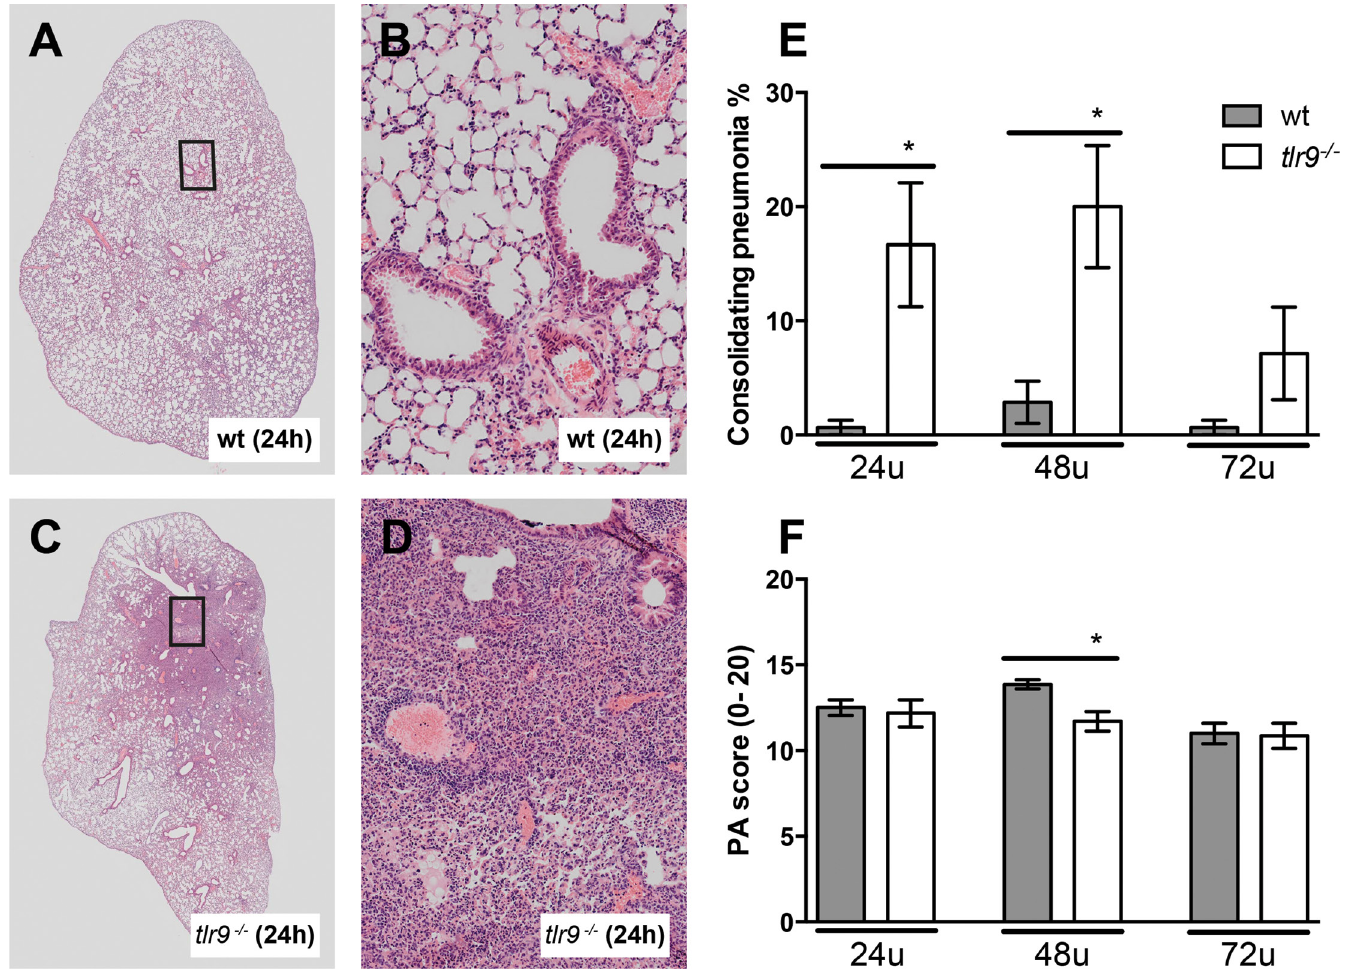
Figure 5. Tlr9 –/– mice show more consolidating pneumonia after induction of S . aureus pneumonia. Representative slides of lung HE staining of (A, B) Wt mice and (C, D) tlr9 –/– mice. (A, C) depiction of a whole lung section; (B, D) ×200 magnification. (E) Consolidating pneumonia and (F) total pathology scores were determined at the indicated time points post infection in Wt mice (gray) and tlr9 –/– mice (white) according to the scoring system described in the online supplement. Data are expressed as bar diagrams depicting mean ± standard error ( n = 7–8 mice per group at each time point). * p < 0.05 versus Wt mice at the same time